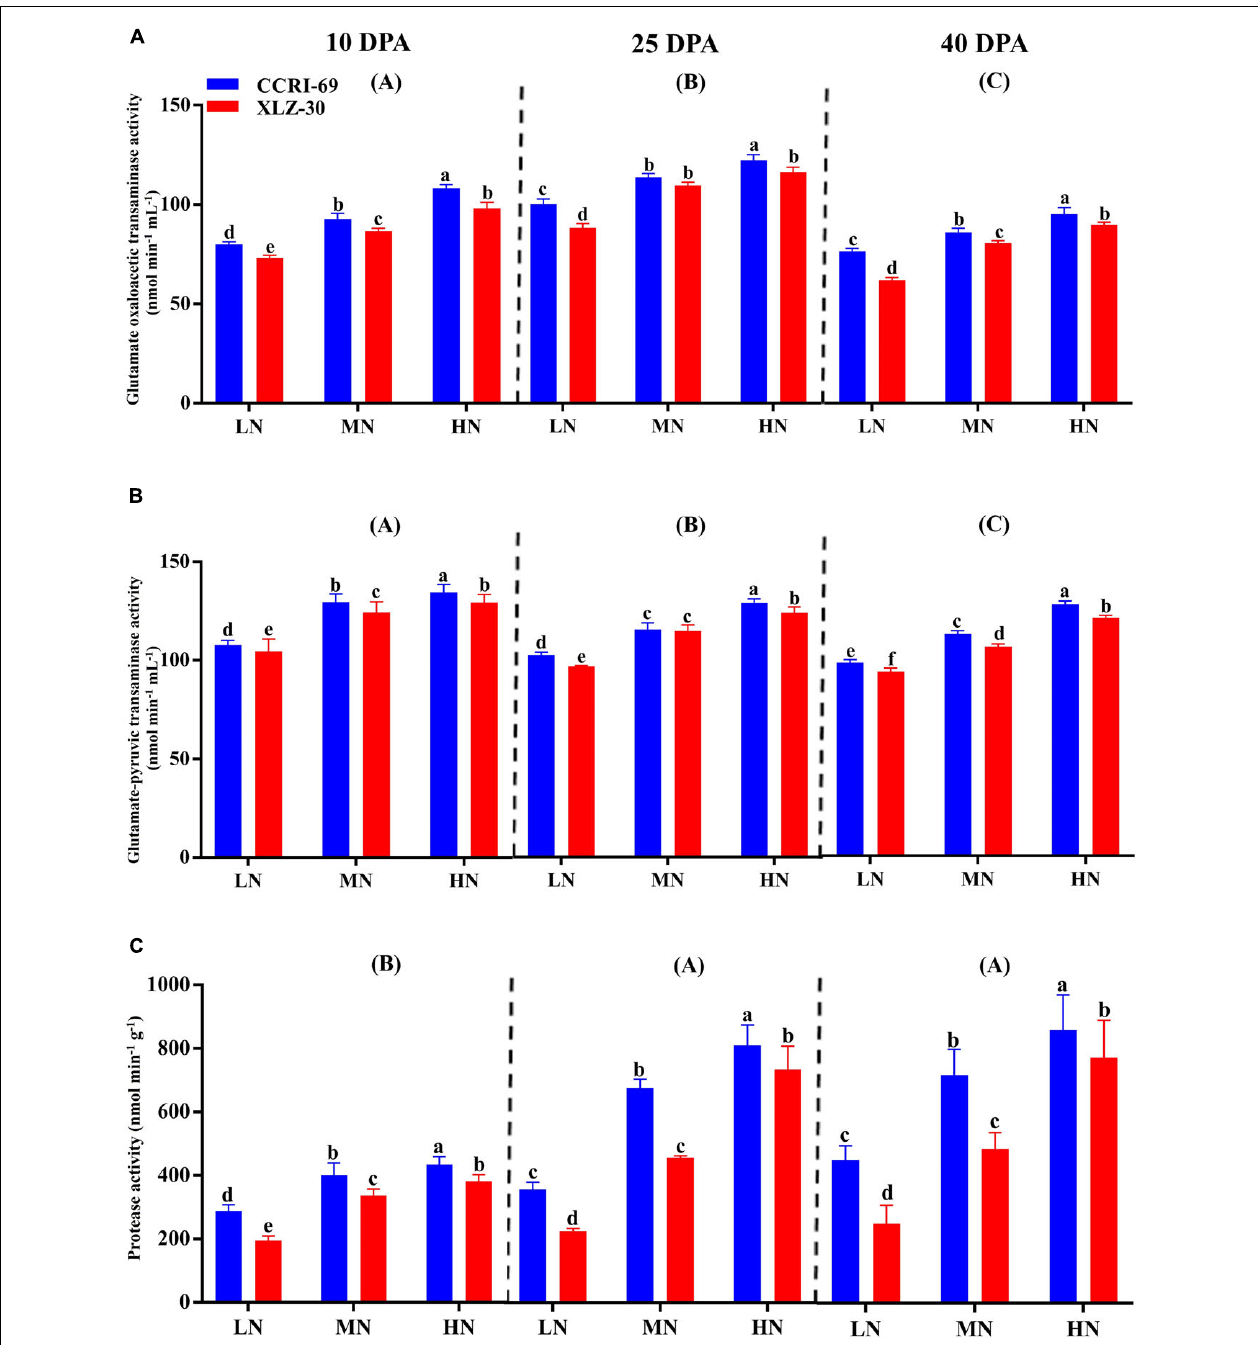
FIGURE 4 | (A–C) Glutamate oxaloacetic transaminase activity (nmol min − 1 mL − 1 ), glutamate–pyruvic transaminase activity (nmol min − 1 mL − 1 ), and protease activity (nmol min − 1 g − 1 ) in cotton subtending leaves of CCRI-69 and XLZ-30 in response to low (LN; 0.25 mM), moderate (MN; 2.5 mM), and high (HN; 5 mM) N levels on 10, 25, and 40 days post-anthesis (DPA). Error bars with different small letters show a significant difference between genotypes under different N levels, and capital letters in the brackets show significant differences among growth stages (10, 25, and 40 DPA) at p < 0.05.